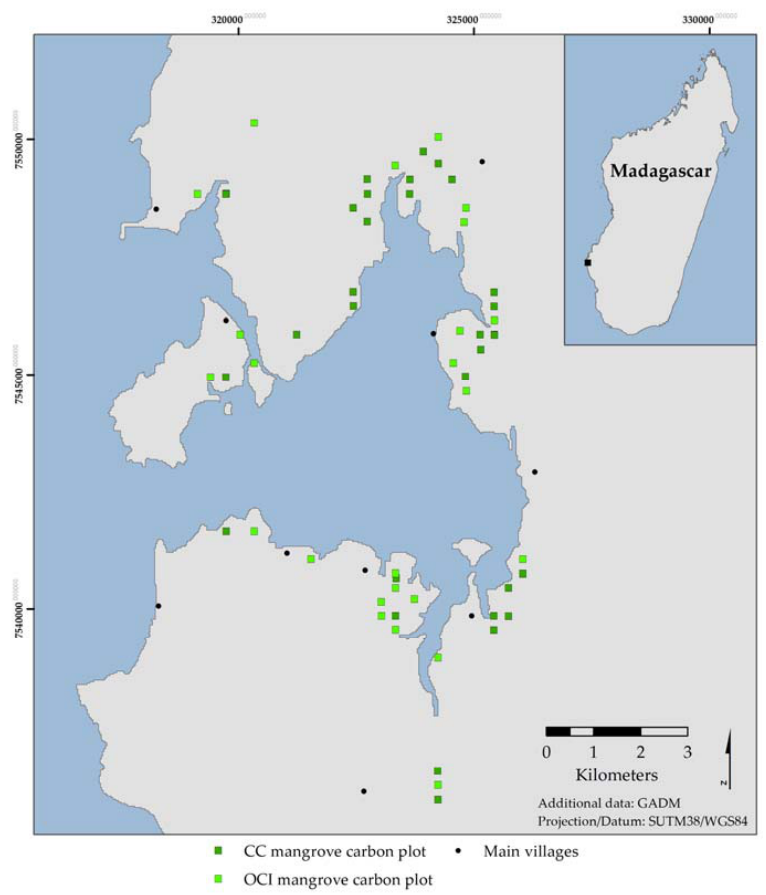
Figure 2. The location and distribution of the 56, 20 × 20 m carbon inventory plots surveyed as part of this study. The plot symbol sizes were selected for visual clarity and do not accurately represent the spatial coverage of the individual plots on the ground.